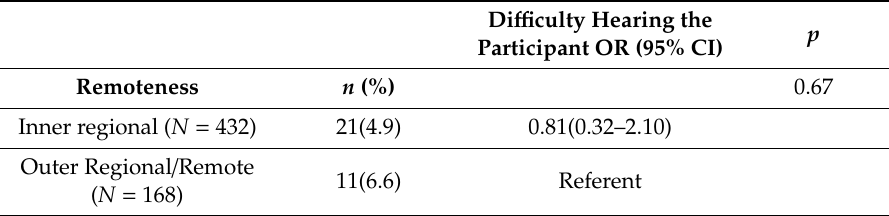
Table 4. Factors associated with connectivity issues during the telephone calls a